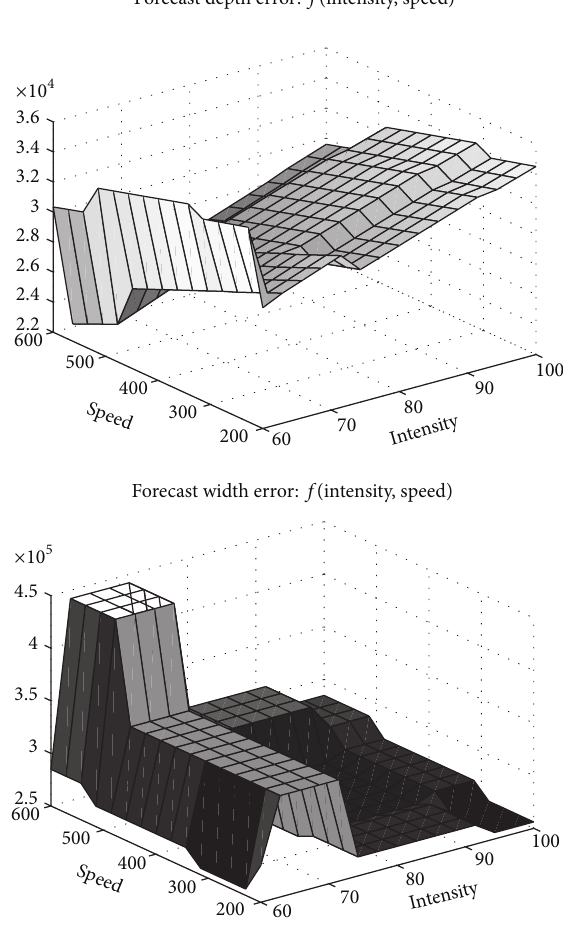
Figure 5: 3D plots of the predicted depth and width’s errors from the Iterated Bagging